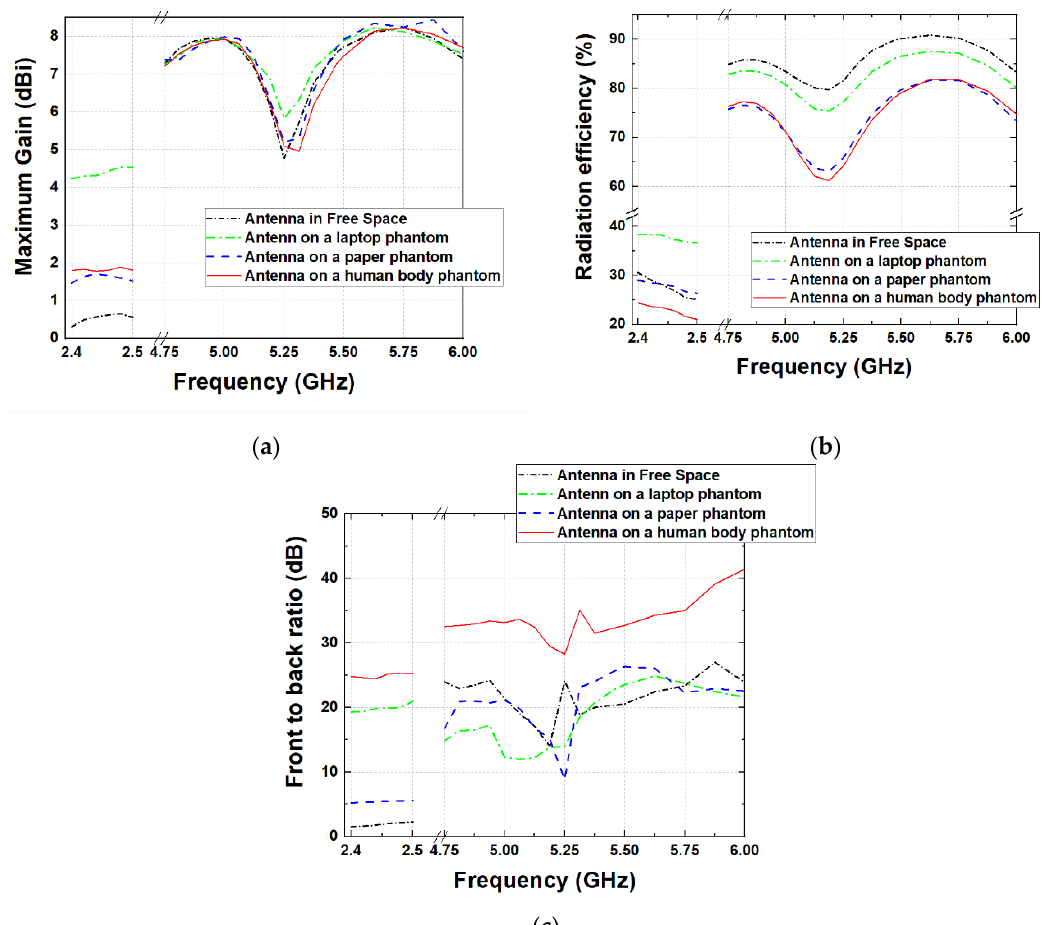
Figure 8. Simulated: ( a ) maximum gain; ( b ) radiation efficiency versus frequency; ( c ) FBR.